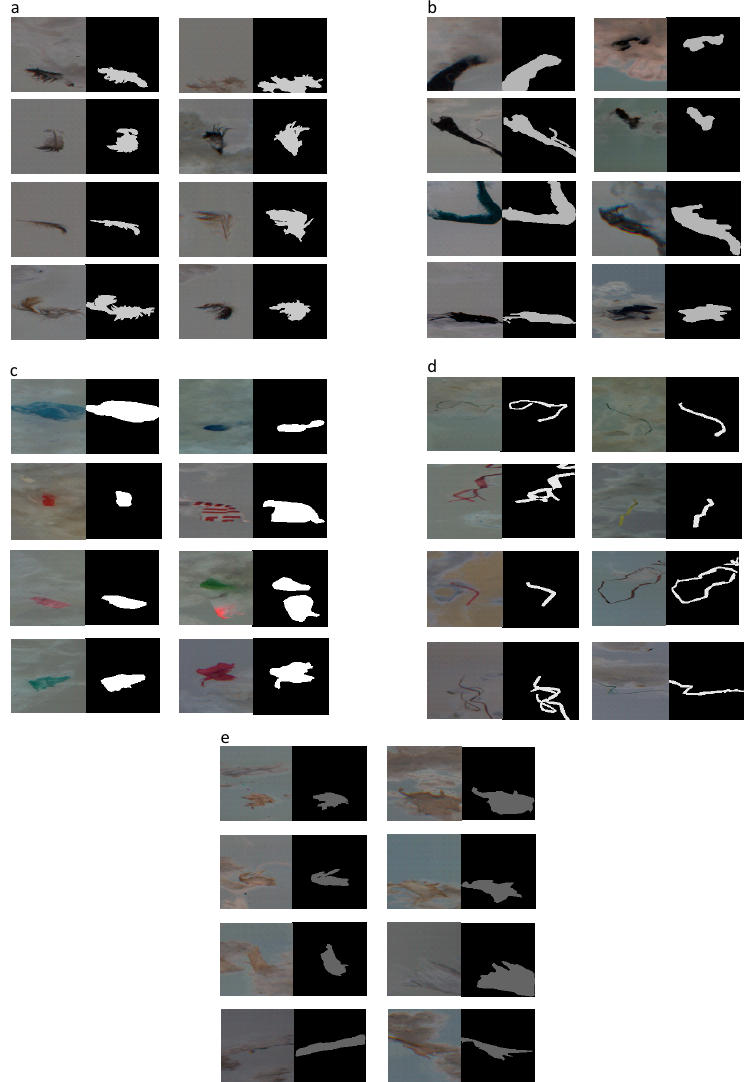
Figure 7. Samples of original and mask images in different classes: ( a ) feather, ( b ) cloth, ( c ) waste paper and plastic, ( d ) polypropylene, and ( e ) mulch film. Table 1. Descriptions of the database